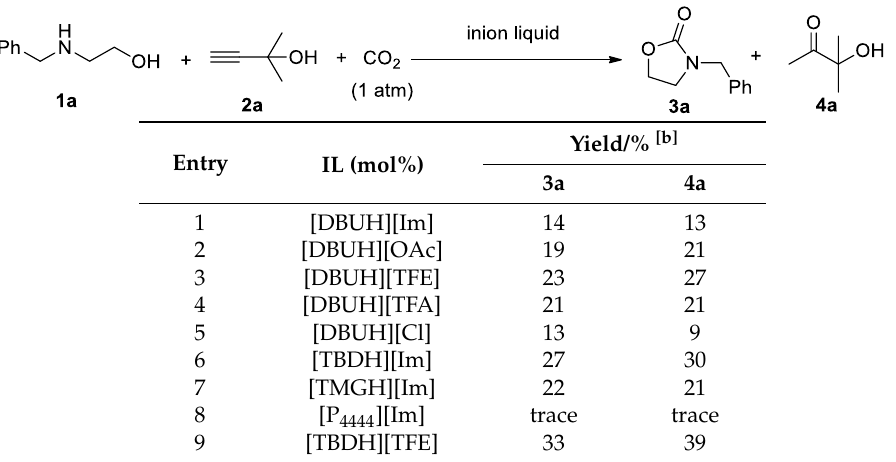
Table 1. Screening ILs for the three-component domino reaction [a] .